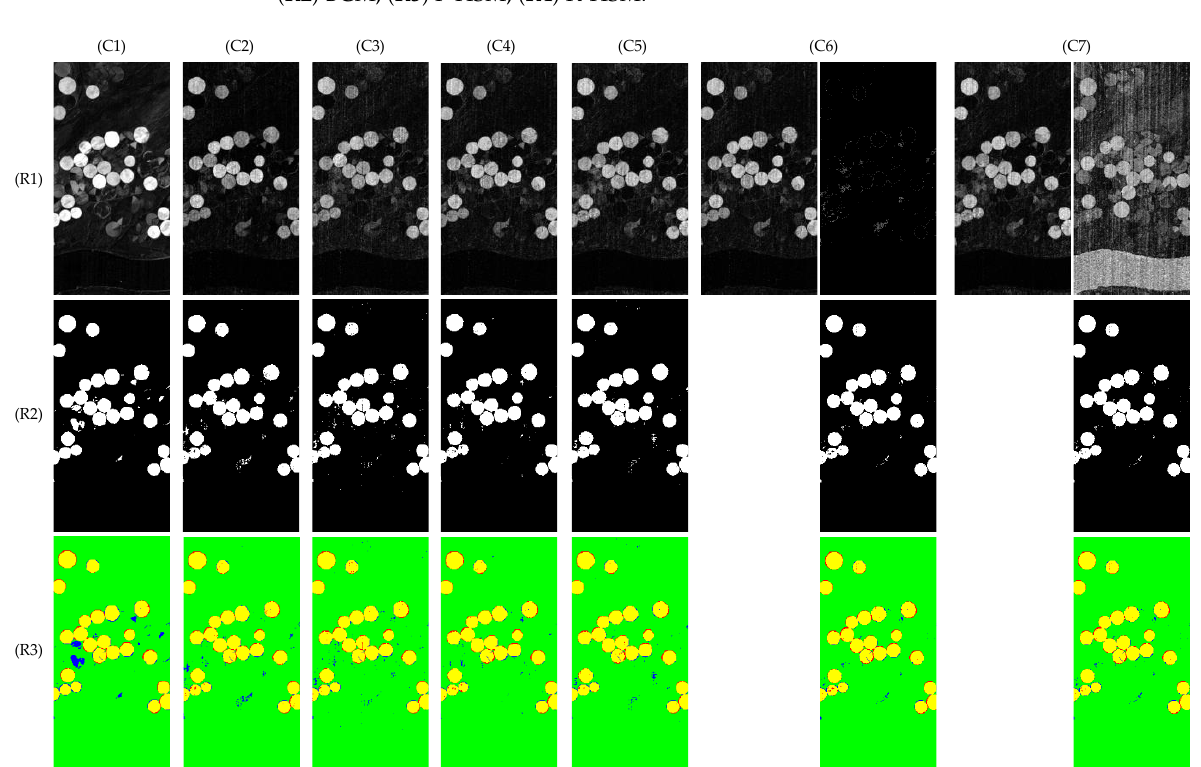
Figure 10. Visualization of comparison on dataset ‘Hermiston’. ( C1 ) CVA, ( C2 ) CD-FCN, ( C3 ) DSFA, ( C4 ) CD-USNet, ( C5 ) CD-CSNet, ( C6 ) CD-SDN-AM, ( C7 ) CD-SDN-AL. ( R1 ) CPM, ( R2 ) BCM, ( R3 ) HSM.